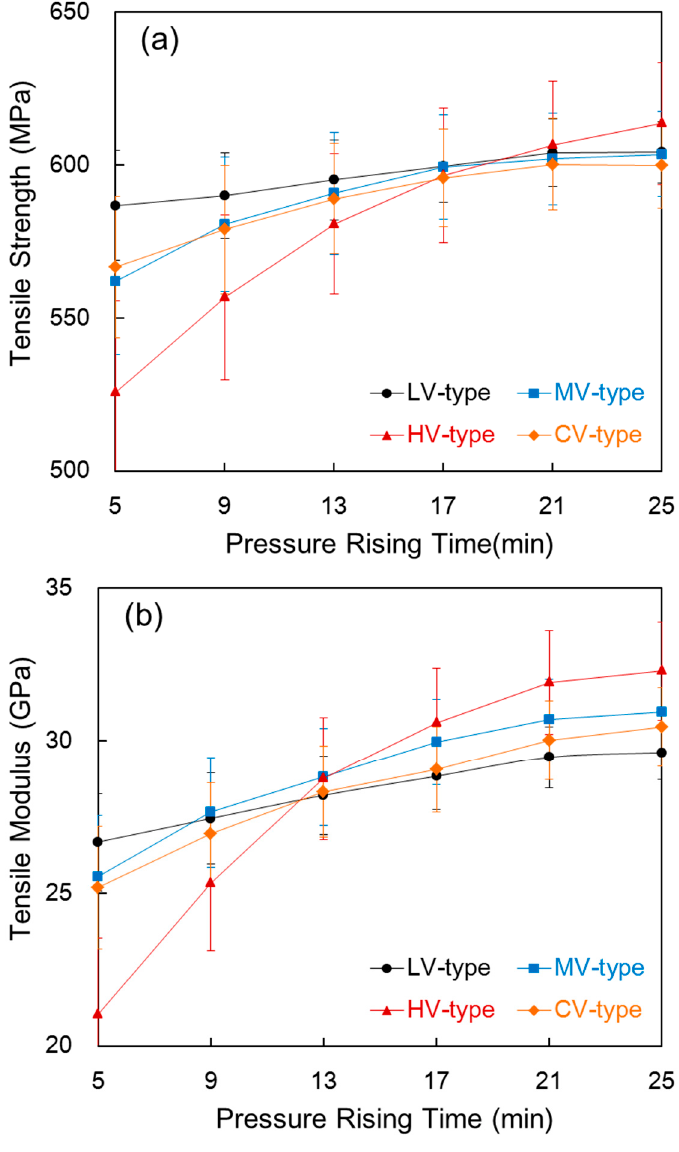
Figure 6. Tensile strength ( a ) and tensile modulus ( b ) of the composite compared with the pressure rising time in each film stacking type.